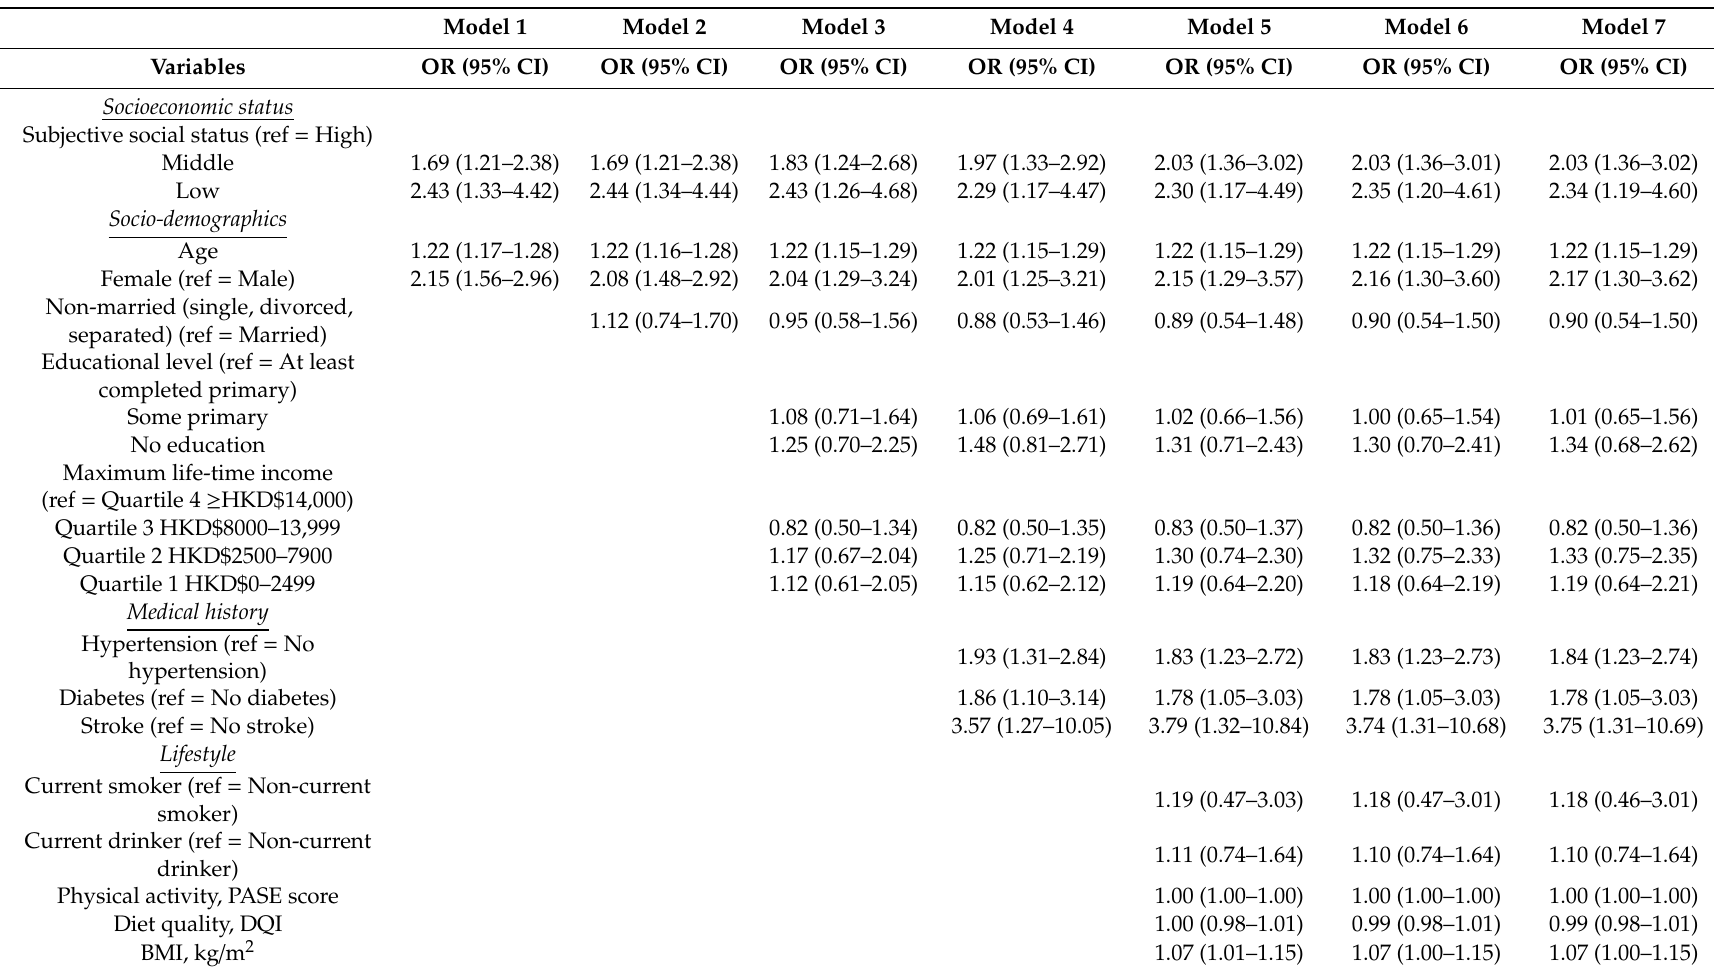
Table 3. Subjective social status (community status ladder) at baseline and the risk of incident frailty at 14-year follow-up, both sexes (n =